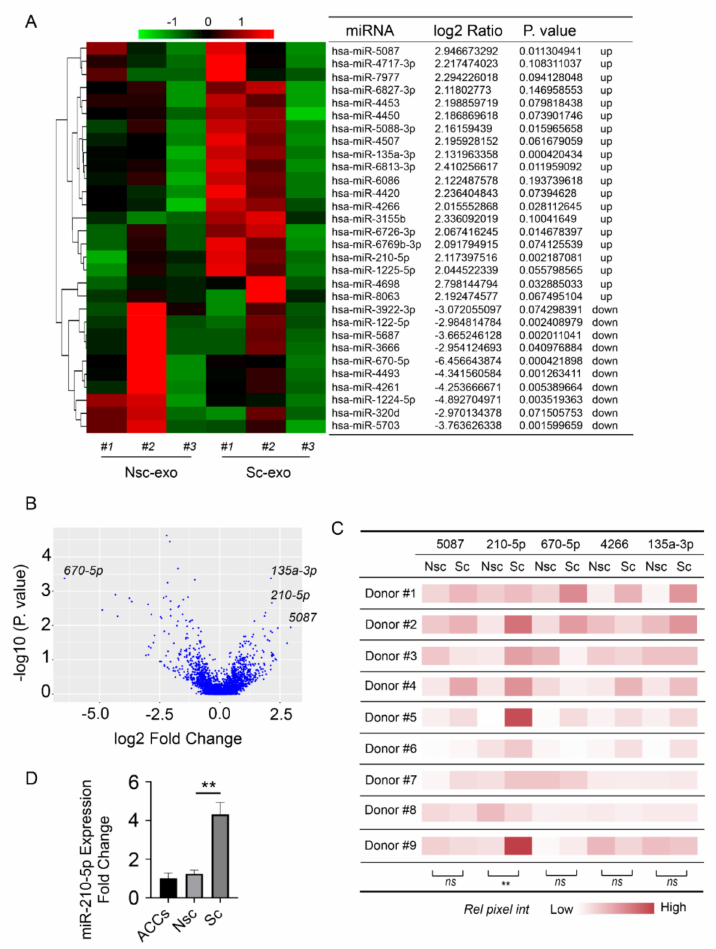
Figure 3. Exosomal miR-210-5p was involved in the abnormal communication between Sc-SBOs and ACCs. ( A , B ) MicroRNA sequencing analysis of Nsc/Sc-SBOs exosomes (n = 3 patients). ( C ) MiR-5087, miR-210-5p, miR-670-5p, miR-4266, and miR-135a-3p in Nsc/Sc-SBOs exosomes were measured using real-time PCR (n = 9). ** p < 0.01. ( D ) Real-time PCR analysis of ACCs treated with/without Nsc/Sc-SBOs exosomes (n = 3), represented as the mean ± SD; ** p < 0.01; ns: Not